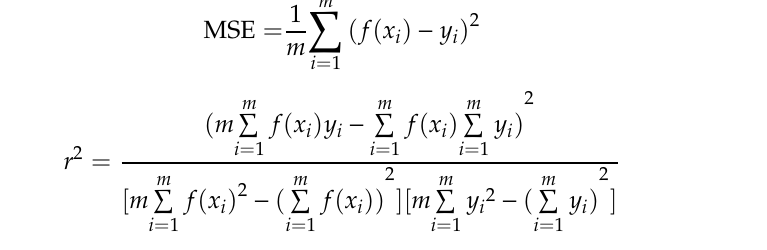
Table 3. Exception information matrix and failure mode probability.